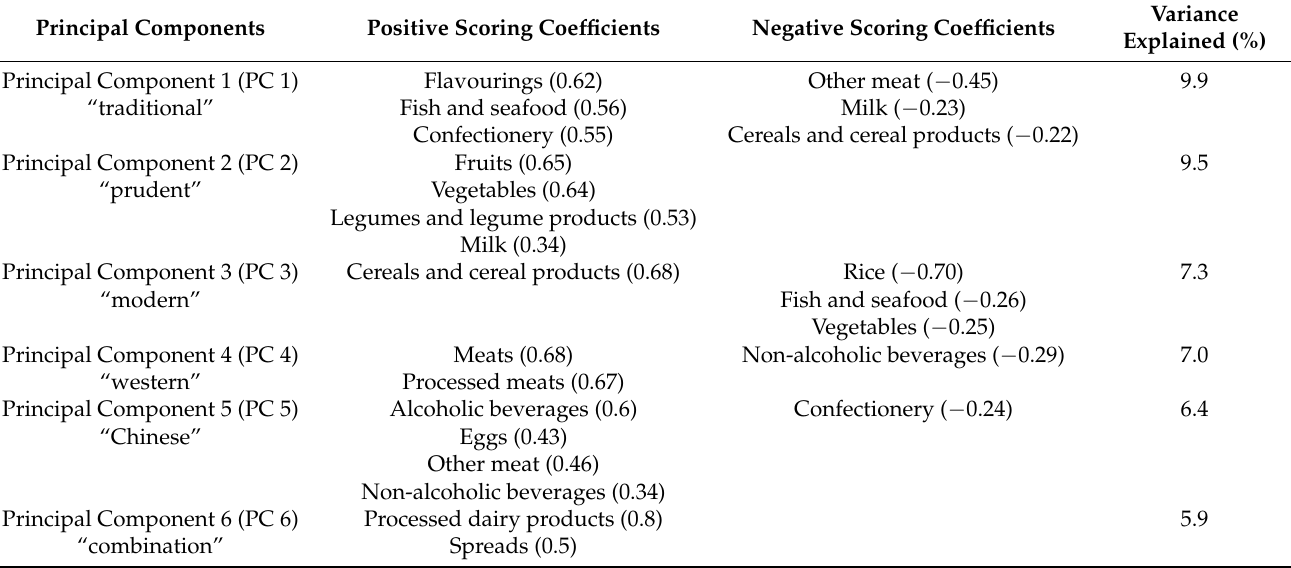
Table 5. Factor loading matrix for the six dietary patterns